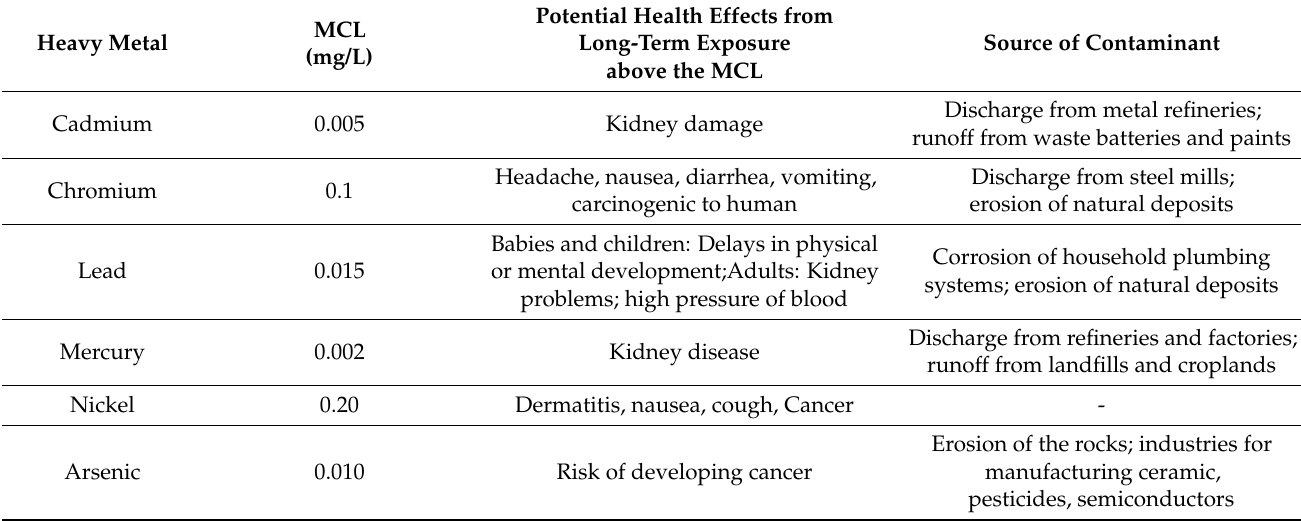
Table 1. Maximum contaminant level (MCL) for some heavy metals in surface waters and their Health Effects. Adapted with permission from ref. [11]. Copyright 2021